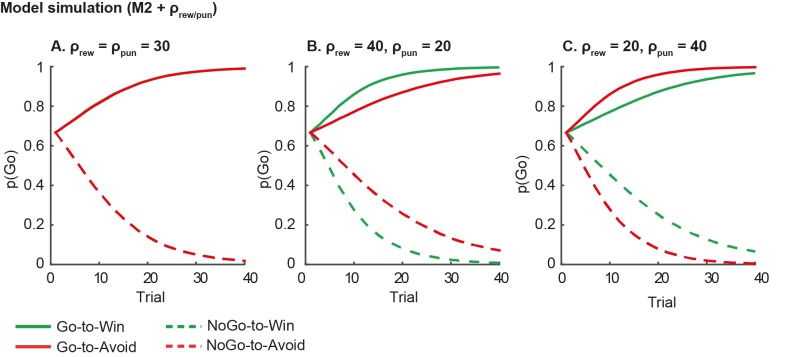
Model predictions of asymmetrical reward/punishment sensitivity (ρrew/pun).Here we simulate data using model M2, which consists of a simple reinforcement learning model and a go bias parameter. We used the fitted group-level parameters (learning rate=.024; feedback sensitivity= 30; go bias = -.2) and averaged over 1000 simulations. A. Model predictions of model M2 without asymmetric sensitivity. The model predicts no differences between Win and Avoid cues, i.e. Go responding matches for Win and Avoid cues. B. Model predictions of model M2 + higher reward sensitivity (reward sensitivity = 40; punishment sensitivity= 20). Stronger reward sensitivity predicts incorrectly that subjects make more NoGo responses for the NoGo-to-Win than NoGo-to-Avoid cues. C. Model predictions of model M2 + higher punishment sensitivity (reward sensitivity = 20; punishment sensitivity= 40). Stronger punishment sensitivity predicts incorrectly that subjects make more Go responses Go-to-Avoid than Go-to-Win cues.